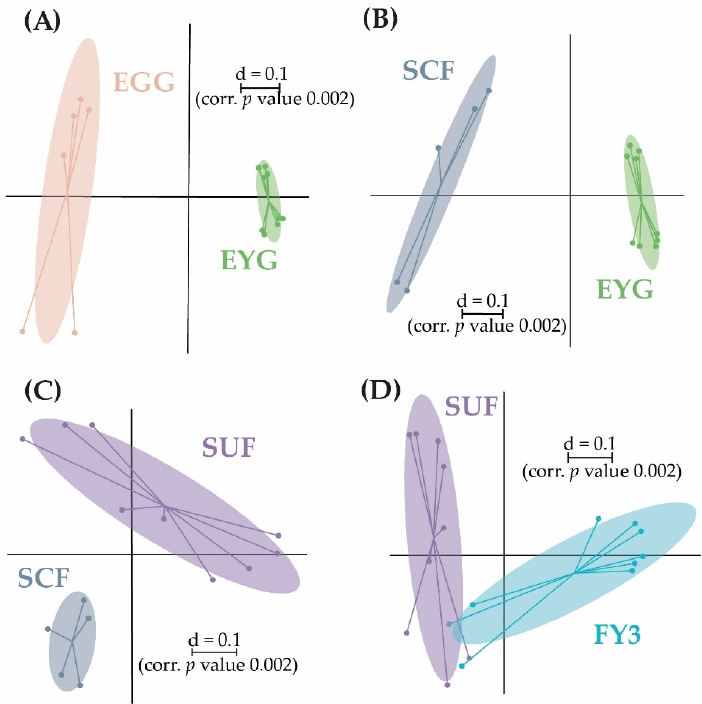
Figure 6. Pairwise β -diversity of the BC of the early developmental stages displayed as a multidimensional-scaling (MDS) plots. The scale is an indicator for the differences in the taxonomic makeup of microbiota between samples ( β -diversity) based on generalized UniFrac distances (d = 0.1 marks a 10% difference). Pairwise β -diversity between EGG and EYG ( A ); EYG and SCF ( B ); SCF and SUF ( C ); SUF and FY3 ( D ). EGG, egg; EYG, eyed egg; SCF, sac fry; SUF, swim-up fry; FY3, fry 82 dpf; dpf, days post fertilization.